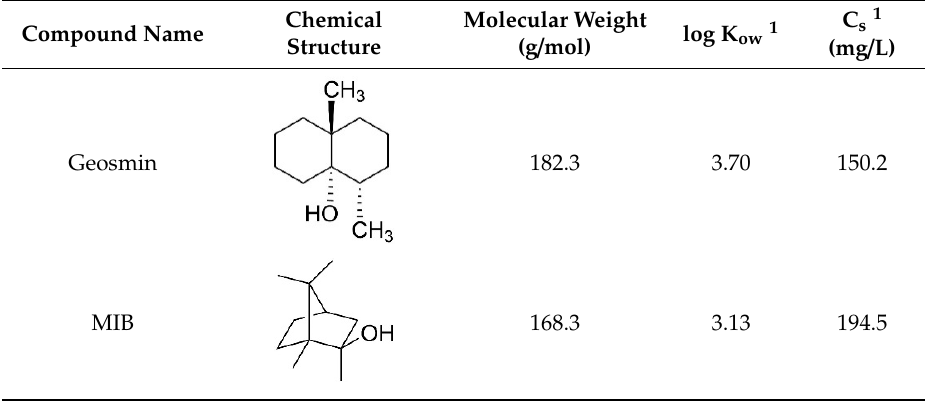
Table 1. Chemical structure, molecular weight, octanol–water partition coe ffi cient (log K ow ), and water